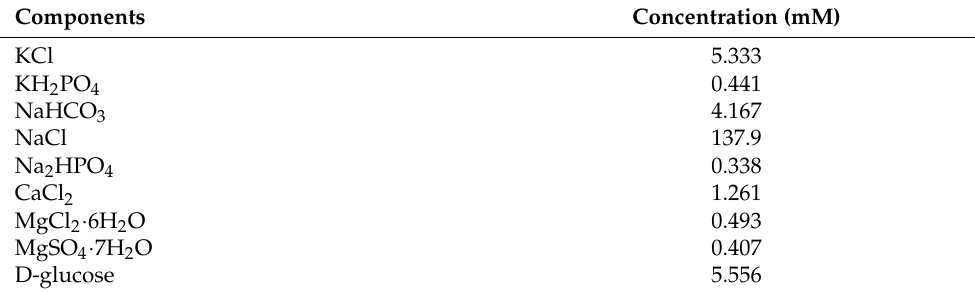
Table 2. Composition of Hanks’